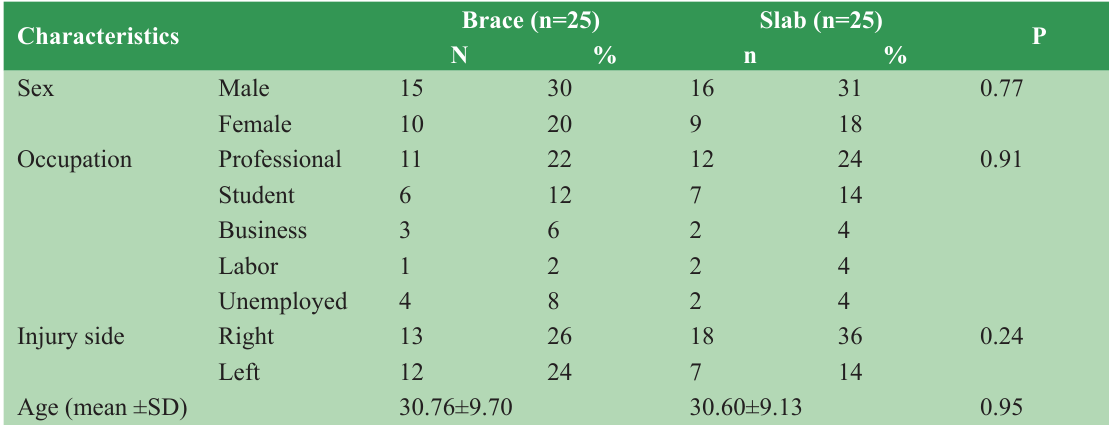
Table 3: Baseline characteristics of patients enrolled in the study Characteristics